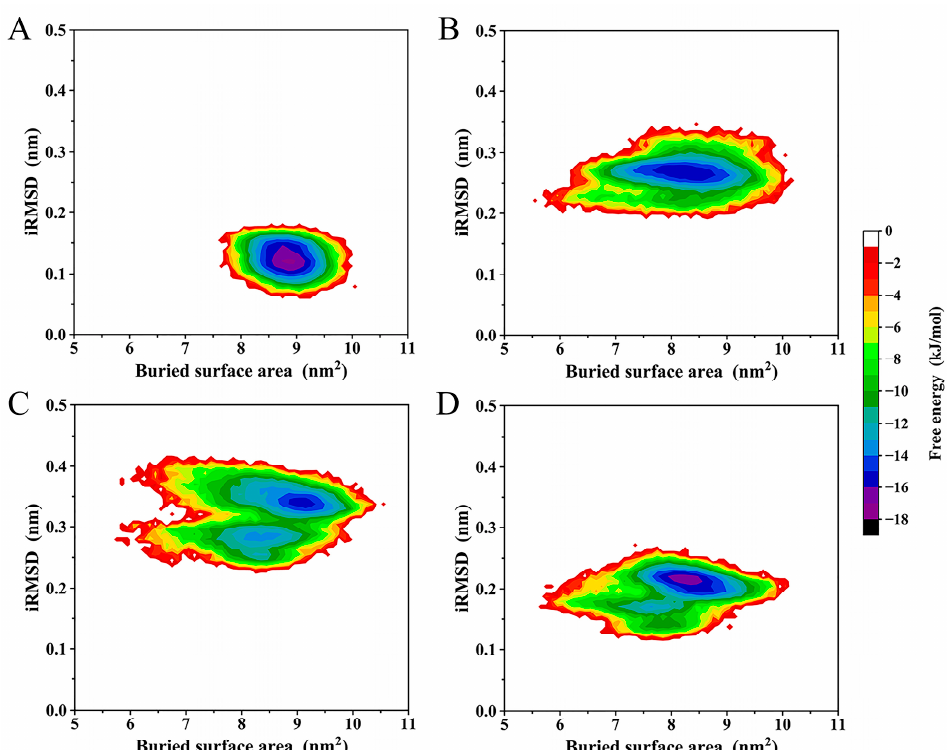
Figure 6. Free energy landscapes (FELs) constructed using the buried surface area and interface RMSD (iRMSD) as the reaction coordinates. ( A – D ) FELs of Mpro-ML188, Mpro-ECI2, Mpro-ECI3, and Mpro-ECI4, respectively. The color bar denotes the relative free energy value in kJ/mol.